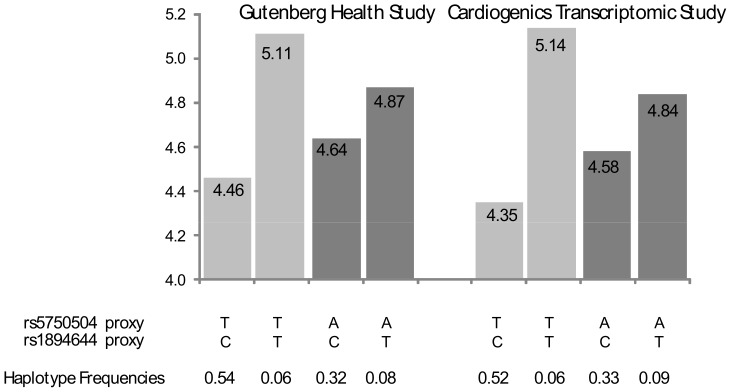

H1F0 rs1894644 × hsa-mir-659 rs5750504 interaction on H1F0 monocyte expression.In the Gutenberg Health Study, the rs1894644/rs5750504 pair was tagged by rs763137/rs2899293. In the Cardiogenics Transcriptomic Study, the corresponding tagging pair was rs1894644/rs6000905.